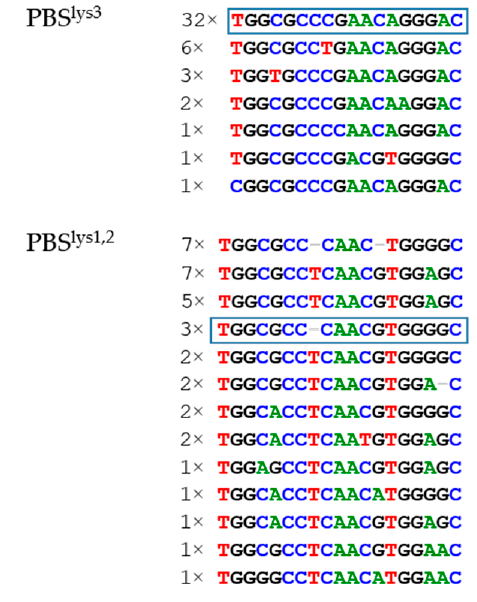
Figure 2. PBS sequences present in 81 full-length Cer-SERV genomes. The consensus sequence of PBS lys3 and PBS lys1,2 is boxed. The number of viral genomes with each variant sequence is indicated. Forty-six Cer-SERV-1 genomes harbor a PBS lys3 , 9 SERV-1 genomes have a PBS lys1,2 or a sequence more closely related to PBS lys1,2 . Twenty-six Cer-SERV-2 genomes have a PBS lys1,2 , three of which are of the wild-type sequence; all seven PBS lys1,2 sequences without a T and a G nucleotide are from a Cer-SERV cluster in P. anubis 15944. Two of three wt PBS lys1,2 sequences are Cer-SERV-1 sequences from T. gelada , and the third is a Cer-SERV-1 provirus from C. sabaeus . Where the majoritycontain an additional T nucleotide (Figure 2). In a murine retrovirus, 2–3 mutations in PBS lys1,2 , including a single nt insertion, have been shown to be tolerated in replication while conveying escape from tRNA fragment (tRF) repression [38]. HIV-1 can likewise allow 1–2 nt insertions in its PBS [39]. Other variation observed in the Cer- SERV-2 PBS sequences are C to T or G to A mutations at CpG dinucleotides. Of note,